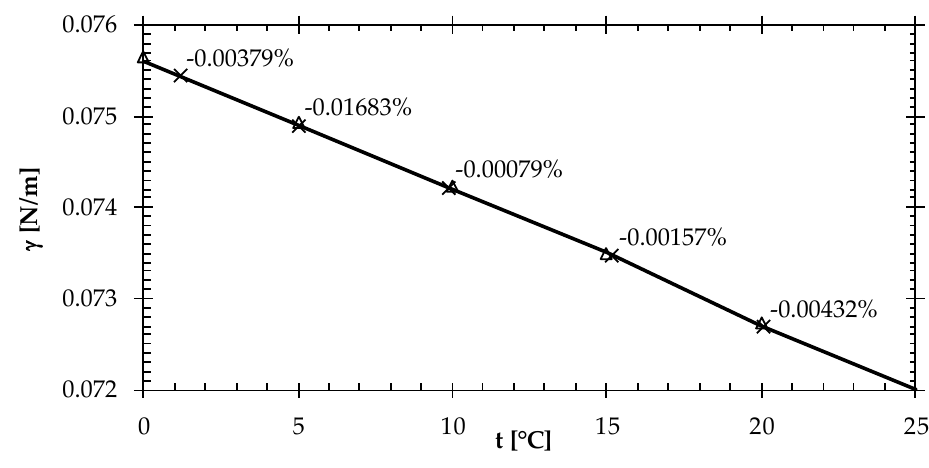
Figure 5. Results obtained from Equation (5) and the reference data from Çengel and Cimbala [33] and IAPWS [36]. The relative discrepancies between the Çengel and Cimbala [33] reference data and the experimental results are presented in the labels.